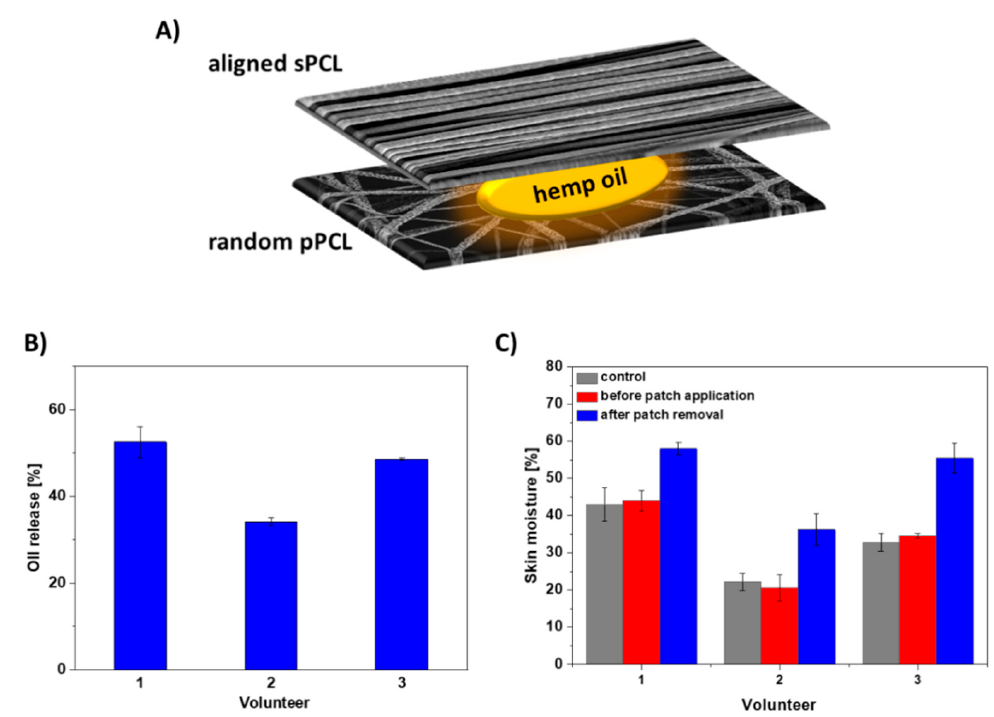
Figure 7. ( A ) Schematic of the layered sPCL/pPCL patches with hemp oil, ( B ) hemp oil release from layered sPCL/pPCL patches within 6 h, and ( C ) skin moisture before and after the sPCL/pPCL patch application on skin of 3 volunteers. The control sample is the layered PCL patch without the oil with the skin moisture data after the patch removal as before its application the skin moisture was at a similar level.